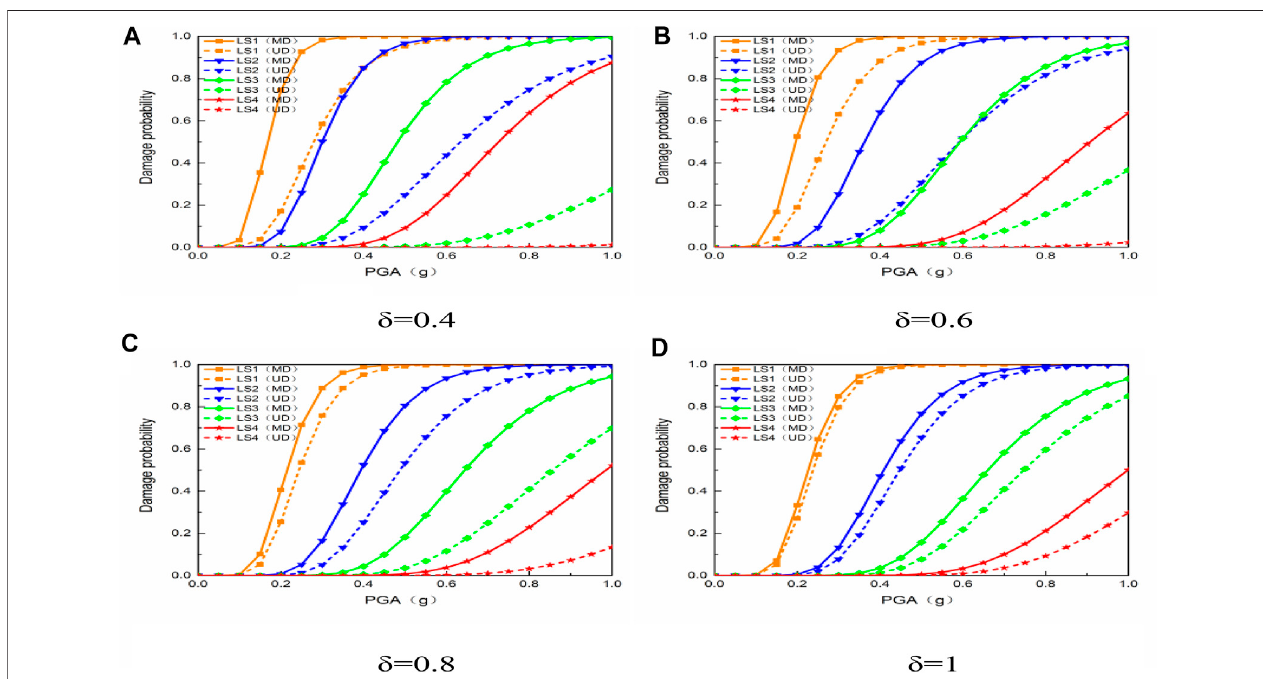
FIGURE 12 | The fragility curves of the undamaged and mainshock-damaged CM model under aftershocks. (A) δ (cid:2) 0.4 (B) δ (cid:2) 0.6 (C) δ (cid:2) 0.8 (D) δ (cid:2) 1.